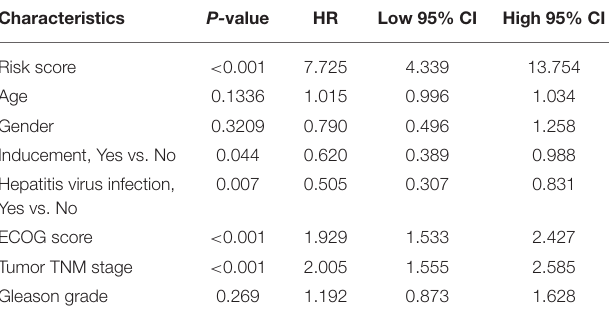
TABLE 3 | Univariable Cox regression of OS in the training cohort.